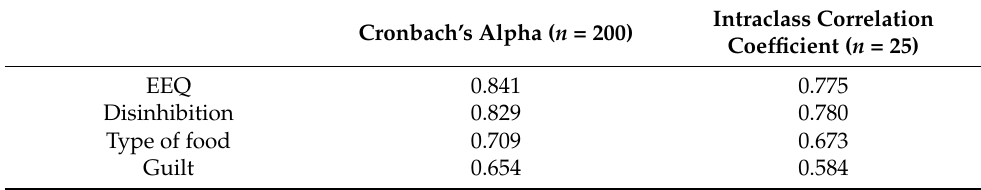
Table 3. Internal and external reliability.